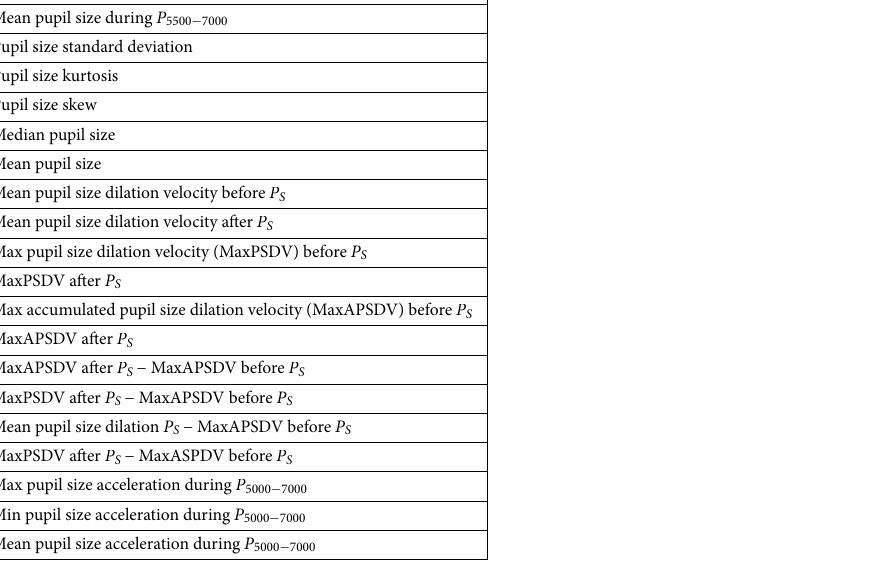
Table 1. Custom pupillometric feature extraction per